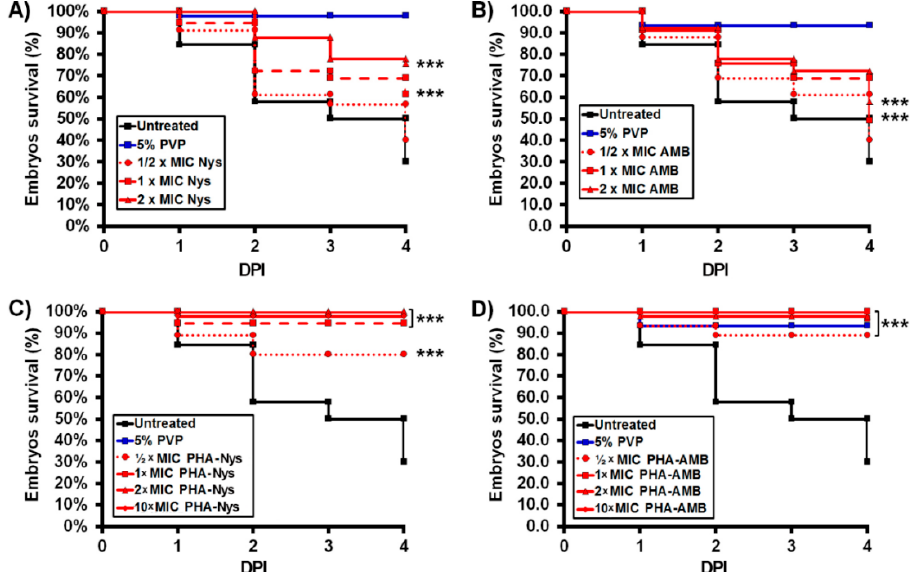
Figure 5. Treatment with PHA/polyene formulations rescued zebrafish embryos of the lethal C. albicans infection. Kaplan-Meier curves of the infected embryos survival upon the treatments with increasing doses of free polyenes ( A , B ) and the corresponding polyene-loaded microspheres ( C , D ) are shown. Embryos were monitored daily for the survival. Data are from four independent experiments using three replicate ( n = 10 embryos/replicates) for each group. Statistically significant differences between the treated and the untreated groups were determined using a Log rank (Mantel-Cox) test (*** p <